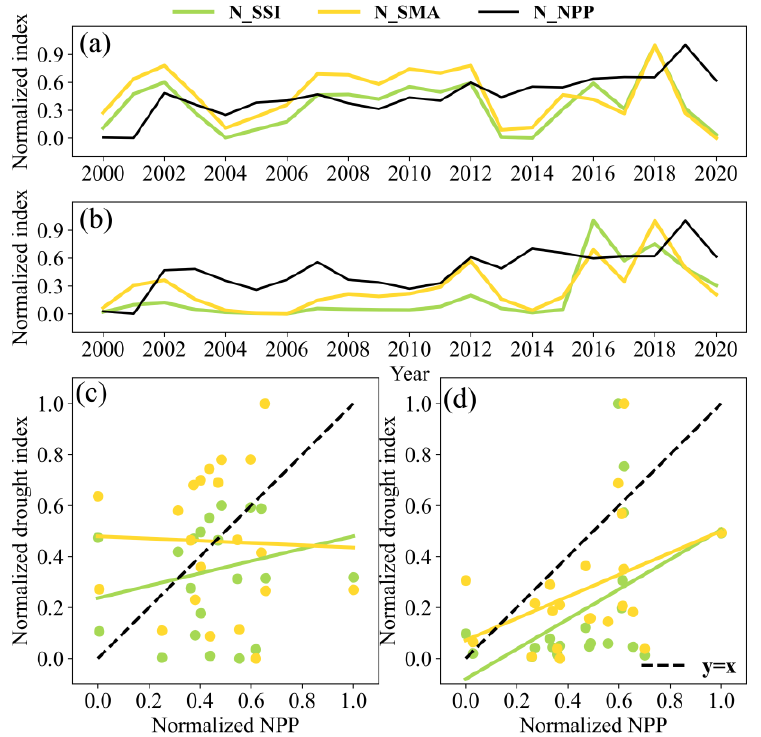
Figure 4. Temporal variation in soil moisture-based drought index and NPP during the growing season from 2000 to 2020: ( a ) grassland and forest area, ( b ) farmland area. The scatter plot of soil moisture drought index and NPP from 2000 to 2020: ( c ) grassland and forest area and, ( d ) farmland area.